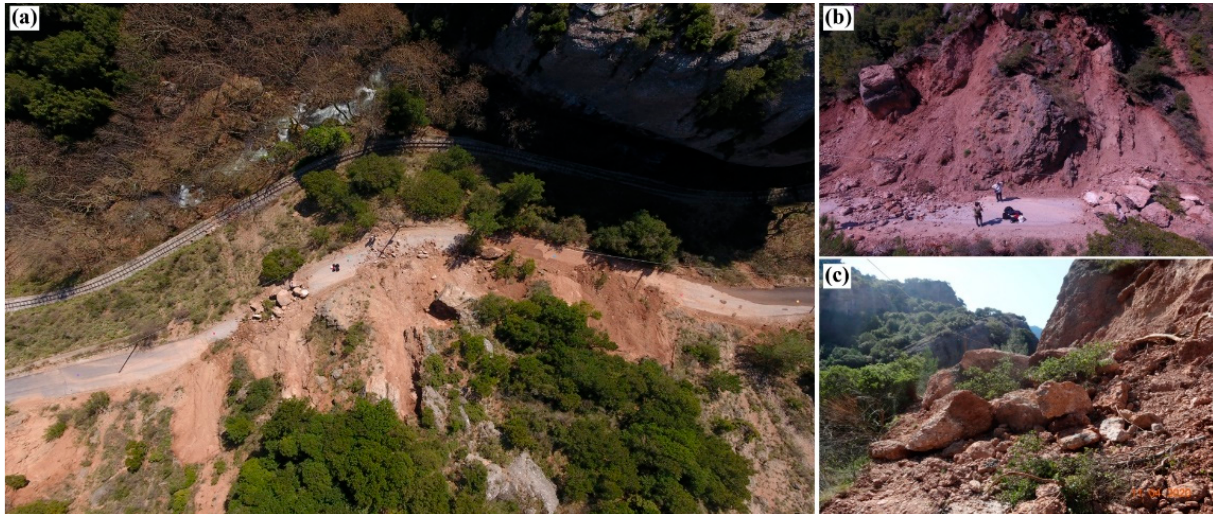
Figure 2. ( a , b ) UAV photos of the area of interest after the landslide on 4 April 2020. ( c ) Photo of the landslide material displaced on the area of the road.